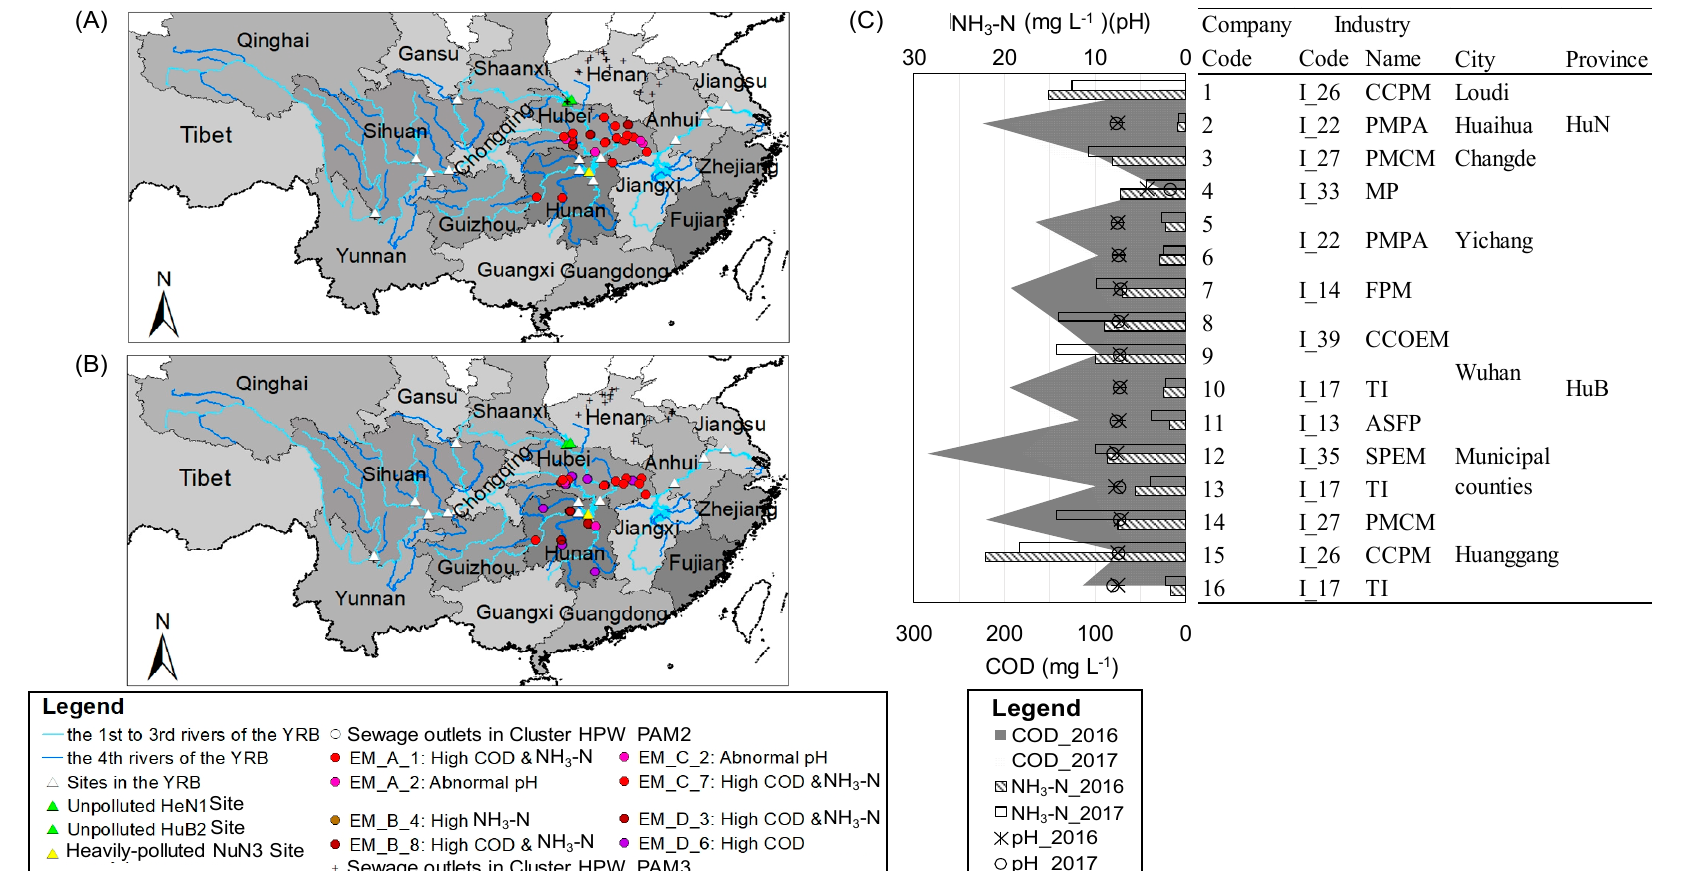
Figure 7. Geographical distribution of sewage outlets with heavily polluted wastewater discharges in the HPZ (heavily polluted zone) with heavily polluted surface water sites and in the UPZ (unpolluted zone) with unpolluted surface water sites in the YRB in 2016 ( A ) and in 2017 ( B ) and the yearly means of COD, NH 3 -N, and pH in the heavily polluted wastewater discharged from the same YRB factories in the HPZ in 2016 and 2017 and their industrial classes and administrative regions ( C ).